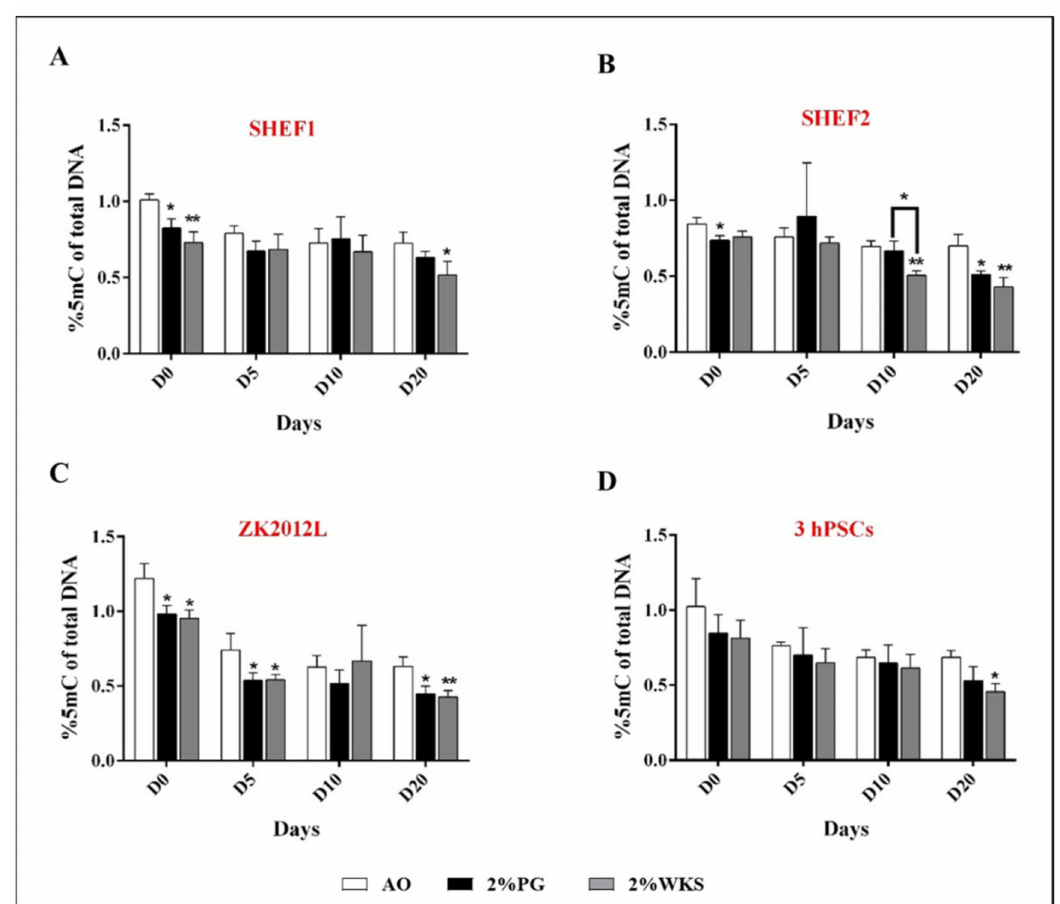
Figure 3. Global 5mC levels in PSCs. ( A ) SHEF1, ( B ) SHEF2, ( C ) ZK2012L, and ( D ) Pooled PSCs- profile, (SHEF1, SHEF2 and ZK2012L) . The methylated DNA fragments of PSCs were analysed using MethylFlash Global DNA Methylation (5-mC) Quantification Kit. Y -axis shows the absorbance (450 nm) of 5-methylcytosine. The X -axis indicates different time points (days). Data are presented as a mean ( n = 3), * p < 0.05, ** p < 0.01 vs. 21% AO, connecting lines indicate significance between conditions, and error bars indicate